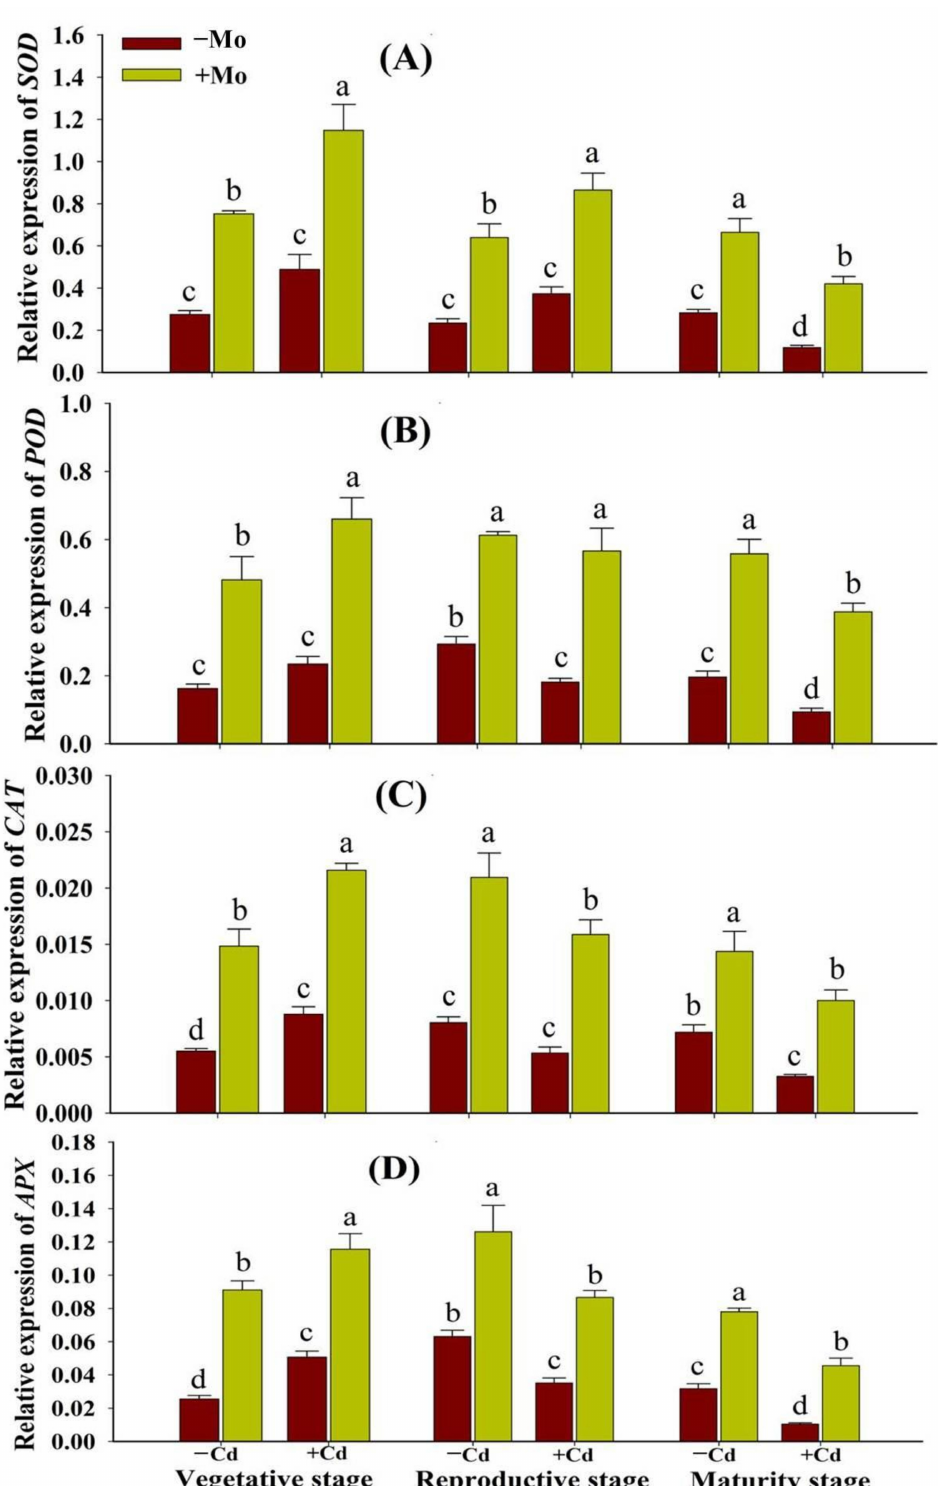
Figure 6. Effect of Mo supply and Cd toxicity on qRT-PCR analysis of antioxidant enzyme-related transcripts of superoxide dismutase (SOD) ( A ); peroxidase (POD) ( B ); catalase (CAT) ( C ); and ascorbate peroxidase (APX) ( D ), in the leaves of aromatic rice ‘Xiangyaxiangzhan’ cultivar, at the vegetative, reproductive, and maturity stages. Bars above means indicate ± S.E. of four independent replicates ( n = 4) and different small alphabetical letters above means reveal significant differences among treatments within a particular growth stage according to the LSD test ( p <